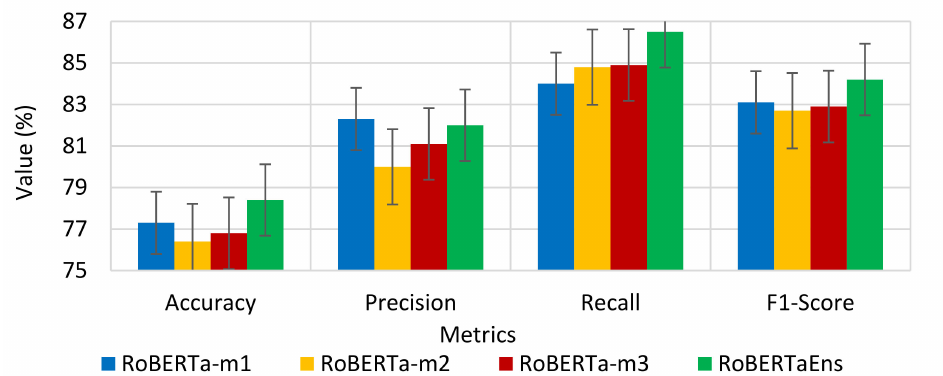
Figure 4. Performance of RoBERTaEns and various RoBERTa models.